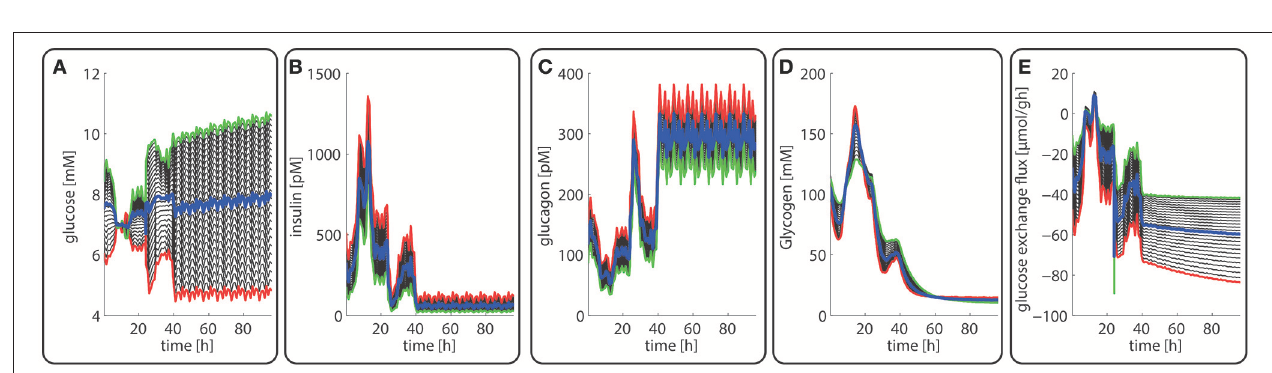
FIGURE 6 | Diurnal variations in the relative abundance of glycolytic and gluconeogenetic enzymes within hepatocytes along the porto-central axis during the transition from a fed state ( t = 0–24h) to a fasted state ( t > 24h). The curves illustrate the relative deviation of protein abundances from the overall spatial and 24h mean ( = 24h mean of the bold red curve). From the top to the bottom, the different curves refer to the spatial position of the hepatocyte counted from periportal to percentral. The bold red line refers to the average protein abundance across all cells. The vertical dotted line indicates onset of the starvation period. (A) GlcT, (B) G6PP, (C) GK, (D) PFK1, (E) FBPPFK1, (F) PFK2, (G) FBPPFK2, (H) PK, (I) PC, (J) PEPCK.